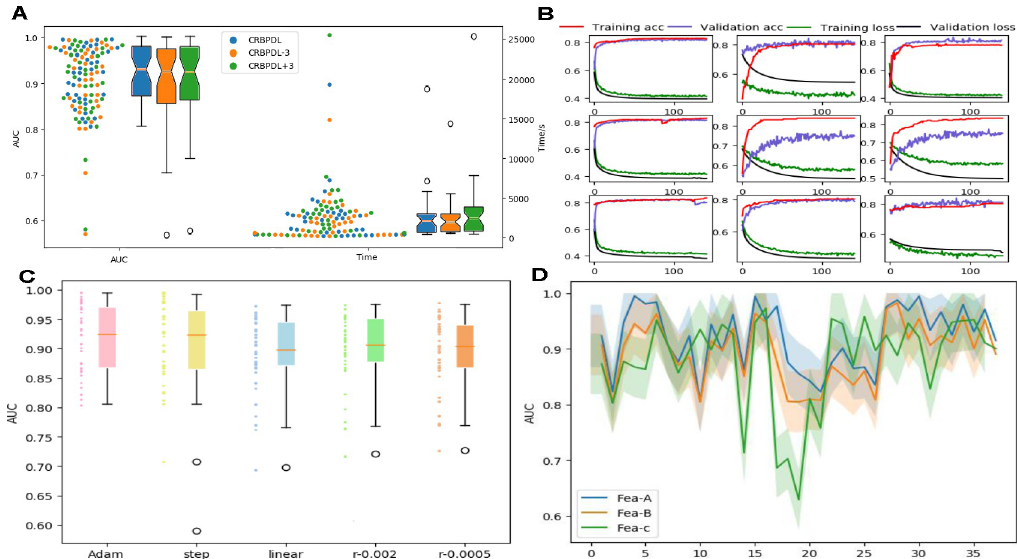
Fig 2. (A) Comparison of model performance between different network depths visualized by box and fiddle charts. (B) Model performance analysis under different EPOCH. (C) Comparison of model performance under different learning rate schemes. (D) Comparison of model performance under different feature coding